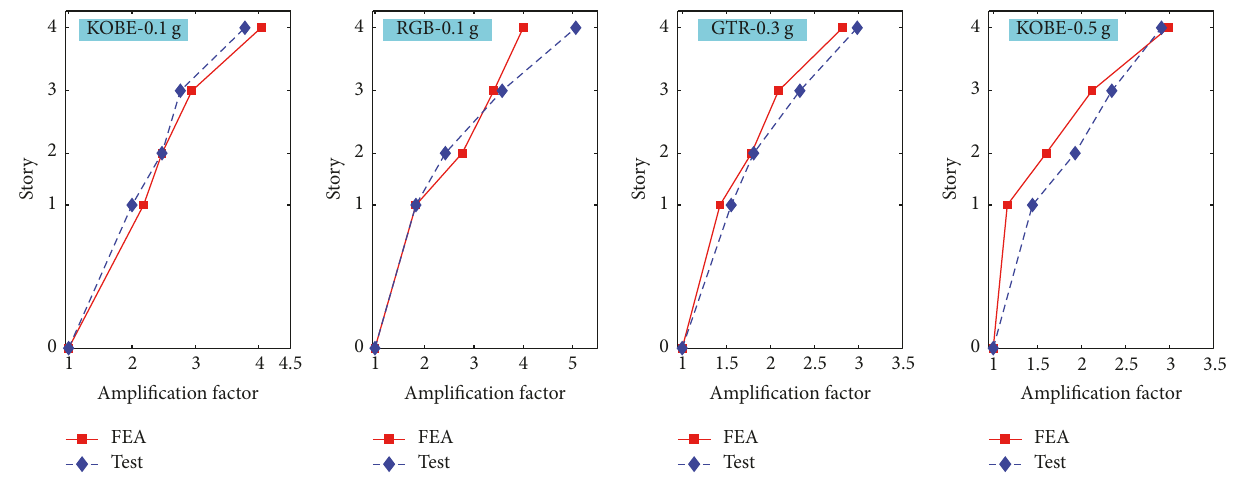
Figure 9: Acceleration amplification factors for different intensity earthquakes.